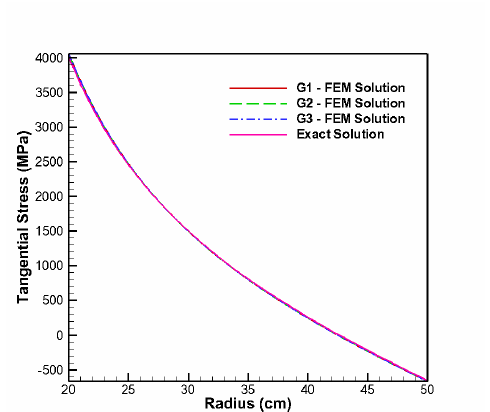
Figure 3. Radial stress under linearly increasing thermal profile, 𝑞 = 50 MPa, 𝑇 𝑖 𝑇 = 500 𝑜 𝐶 and 𝜔 = 350 rad/s 𝑟 𝑜